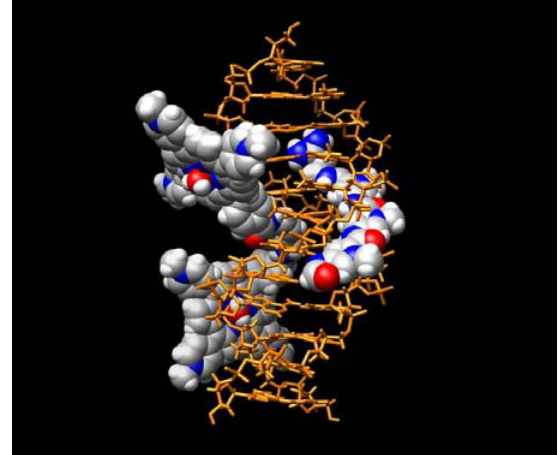
H TMPyP (open squares), H 2